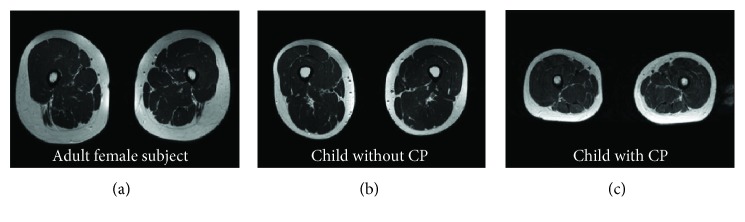
Representative MR image of the shank of (a) adult female subject, (b) child without CP, and (c) child with CP.